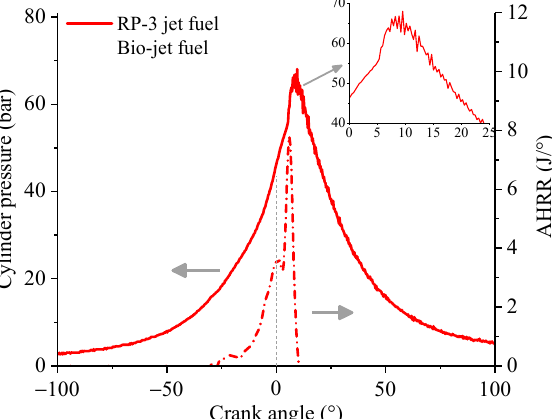
Figure 9. Variation of cylinder pressure and AHRR of one cycle for the bio-jet fuel at 64% throttle opening.